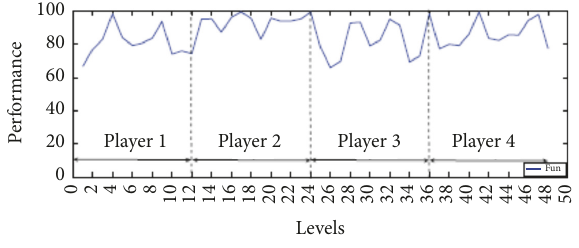
Figure 5: Four-player optimized levels of